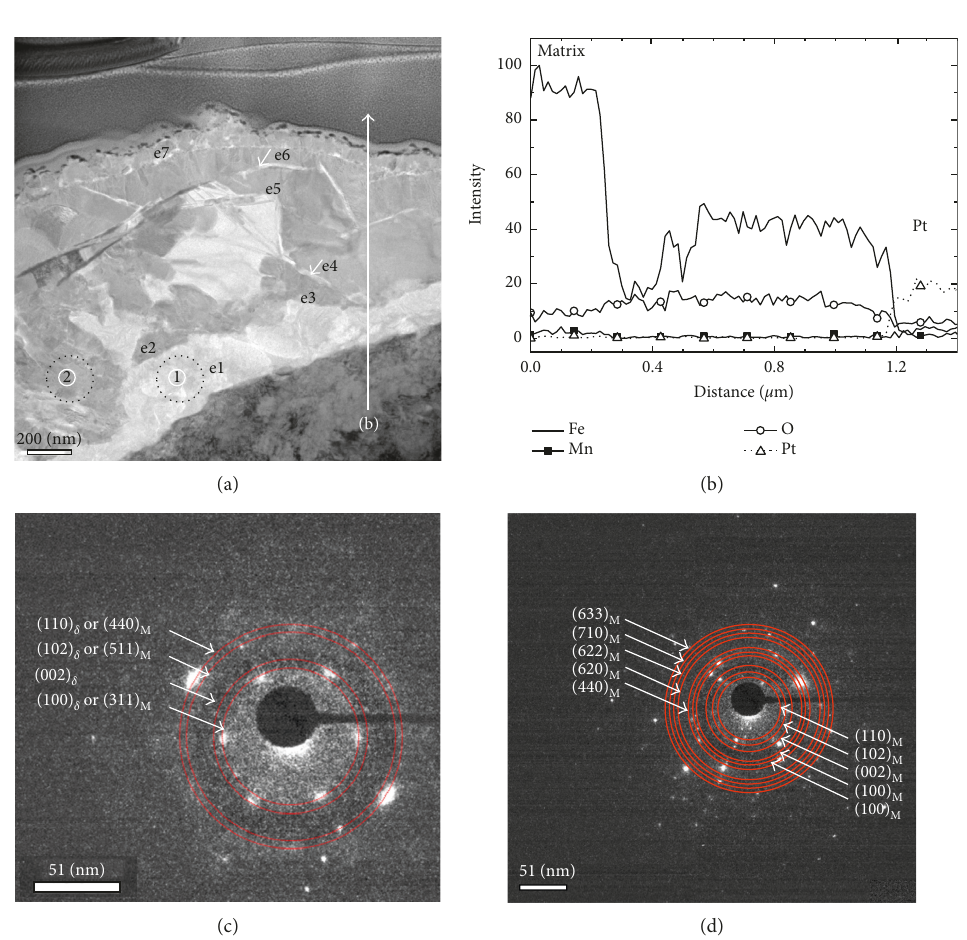
Figure 6: Cross-sectional TEM image (a), EDS line profile (b), and SAEDs (c-d) of regions 1 and 2 in rust formed during 56-day immersion of REF in 3.5% NaCl solution at 60 o C, where the subscripts δ and M indicate feroxyhyte and magnetite,